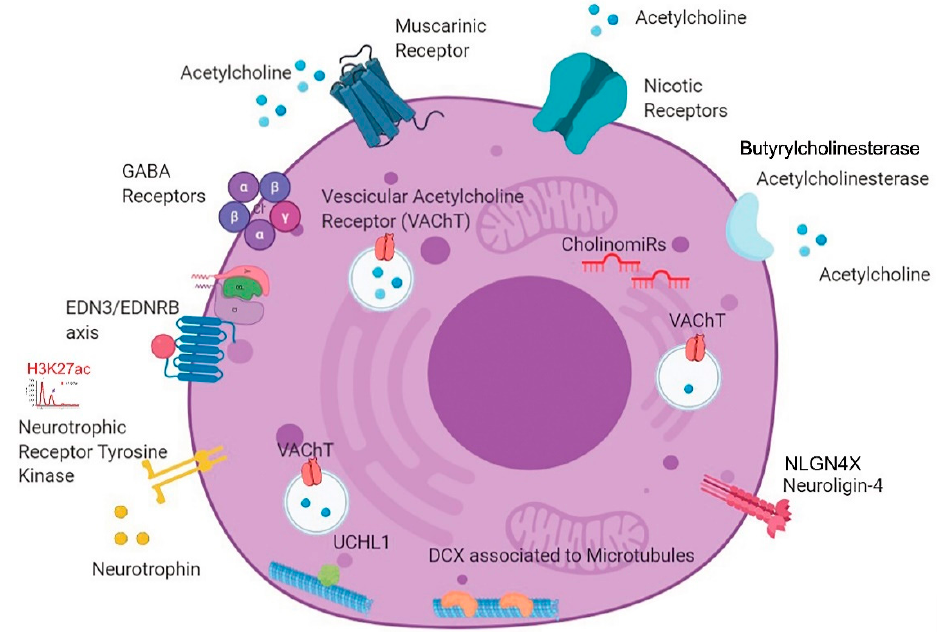
Figure 5. New BPDCN cell model. The cartoon summarizes all the neural features detected in BPDCN tumor cells by IHC (positivity for DCX, UCHL-1 and VAChT), RNA sequencing (overexpression of muscarinic and nicotinic receptors for acetylcholine, butyrylcholinesterase and acetylcholinesterase genes, GABA receptors, neurotrophins and neurotrophic receptor tyrosine kinase genes), miRNA network analysis (EDN3 and NLGN4X), miRNA expression profiling (deregulation of CholinomiRs,) and chromatin immunoprecipitation sequencing (H3K27ac). (Created with BioRender.com, accessed on 21 August 2020 ) .